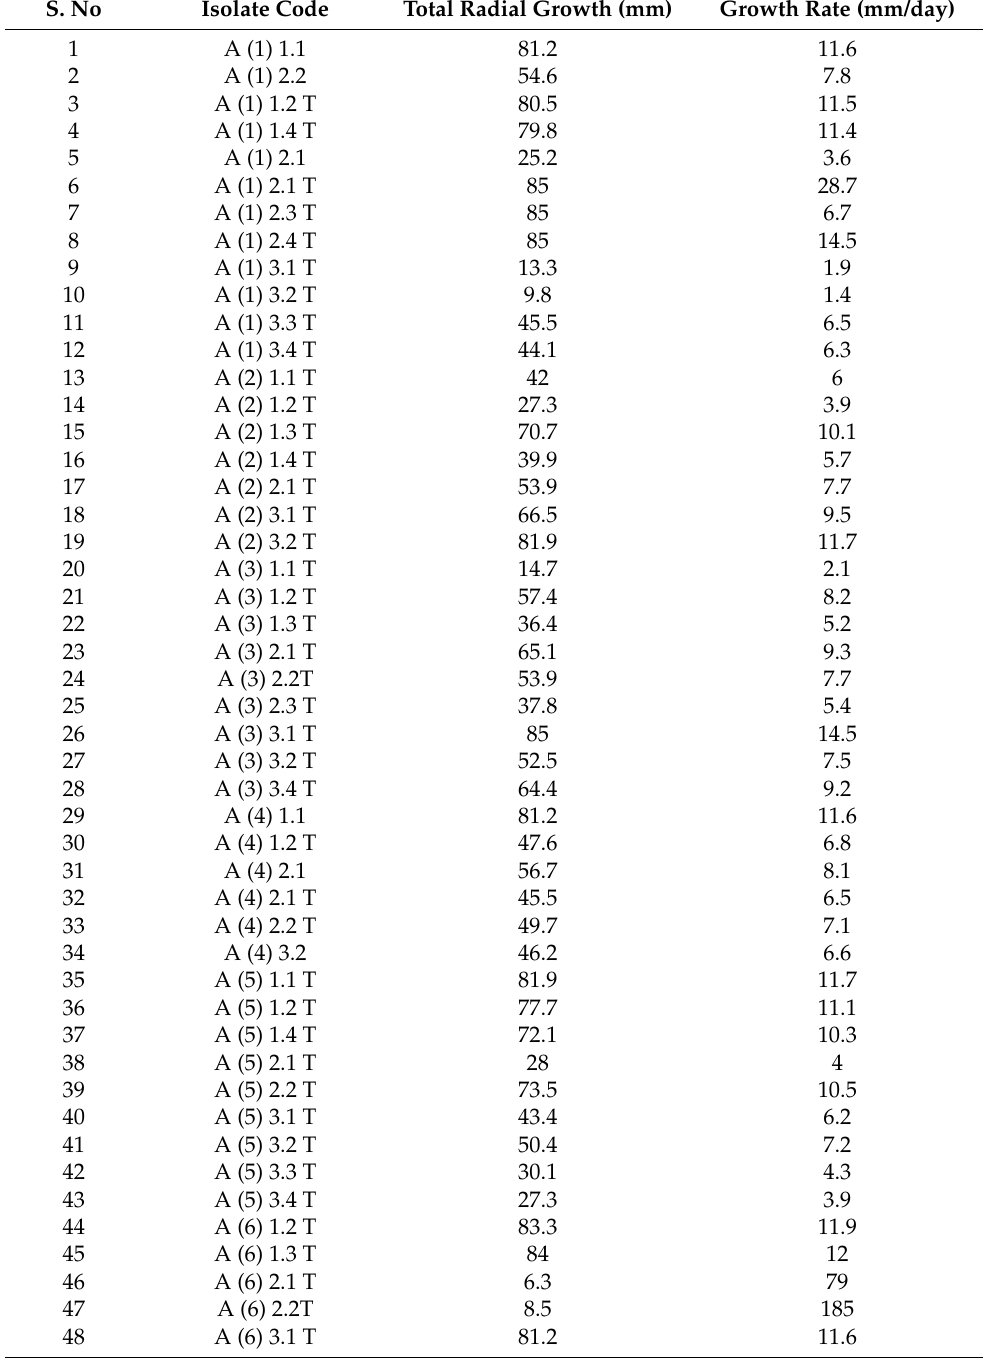
Table 2. Total radial growth (mm) and growth rate (mm/day) of different isolates of Trichoderma spp., on